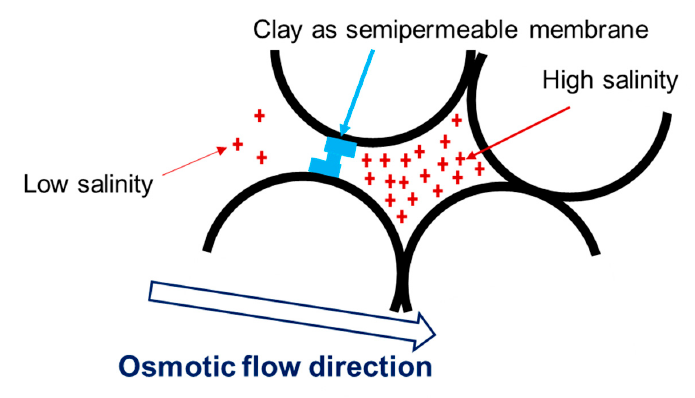
Figure 4. The schematic showing osmosis effect on fluid flow in clay-rich rocks.